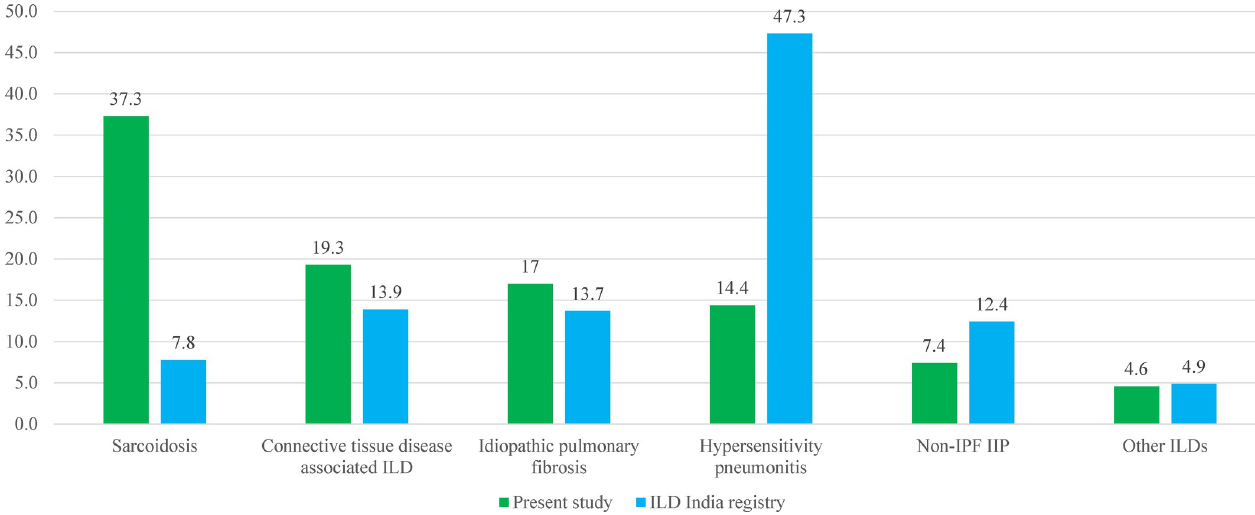
Fig 1. Comparison of spectrum of interstitial lung diseases in this study and a large (n = 1,084) multicenter study from India. [18] The numbers represent percentage of subjects diagnosed with the condition.